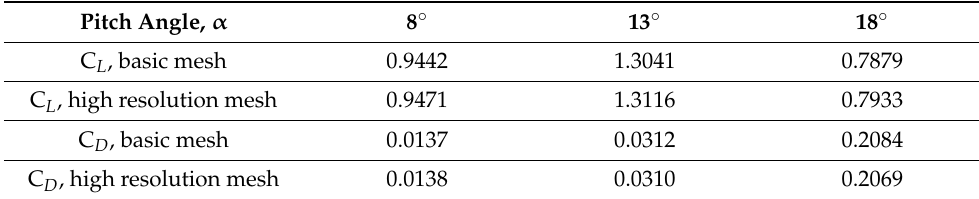
Table 1. Obtained mesh convergence analysis